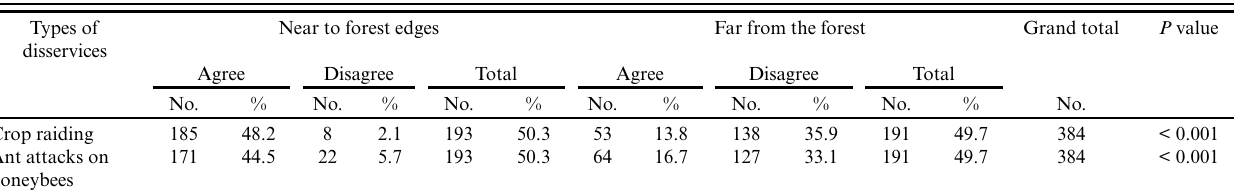
Table 5. Farmers’ responses regarding the challenges posed by crop raiding by wild animals and beehives attacked by ants as ecosystem disservices near to and far from forests. P values are from chi-square tests. Types of disservices